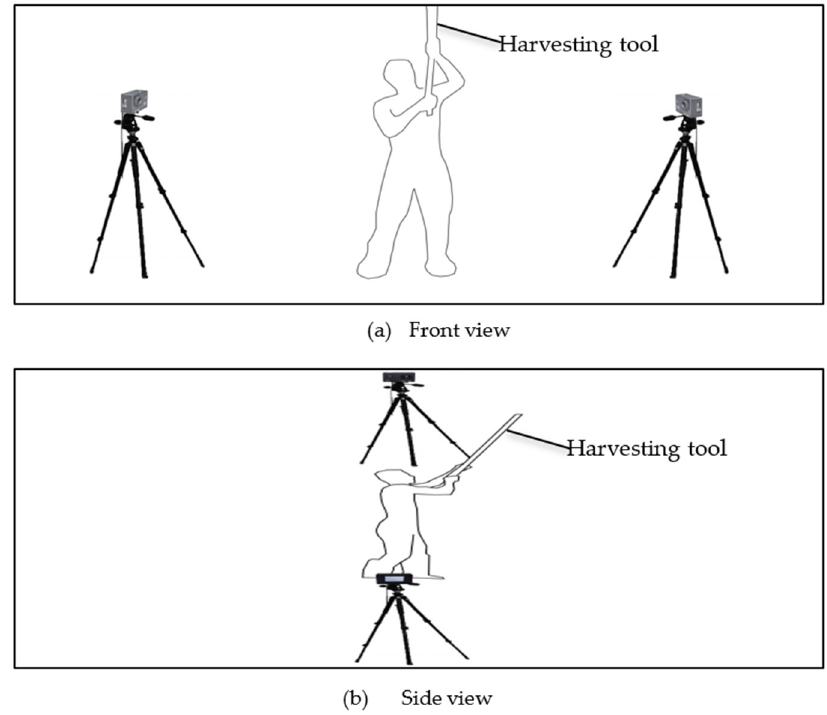
Figure 1. ( a ) Front and ( b ) side view of the camera positions to capture the harvesting of FFBs movement at the sagittal plane.